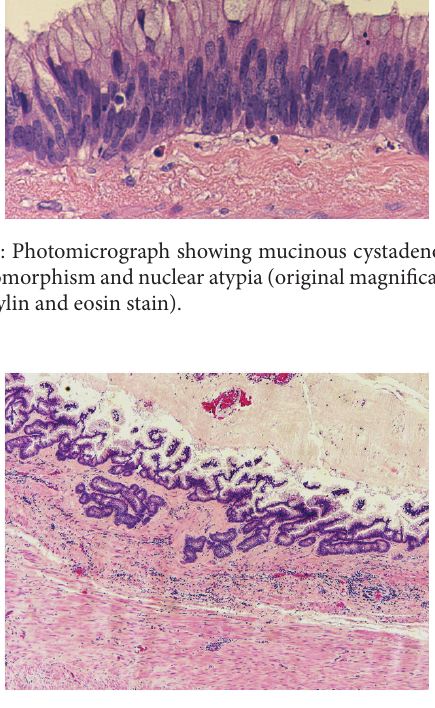
Figure 6: Photomicrograph showing low grade mucinous cystade- nocarcinoma. The tumor cells with a full-thickness nuclear stratifi- cation and increased mitotic figures (arrow) (original magnification × 40, hematoxylin and eosin